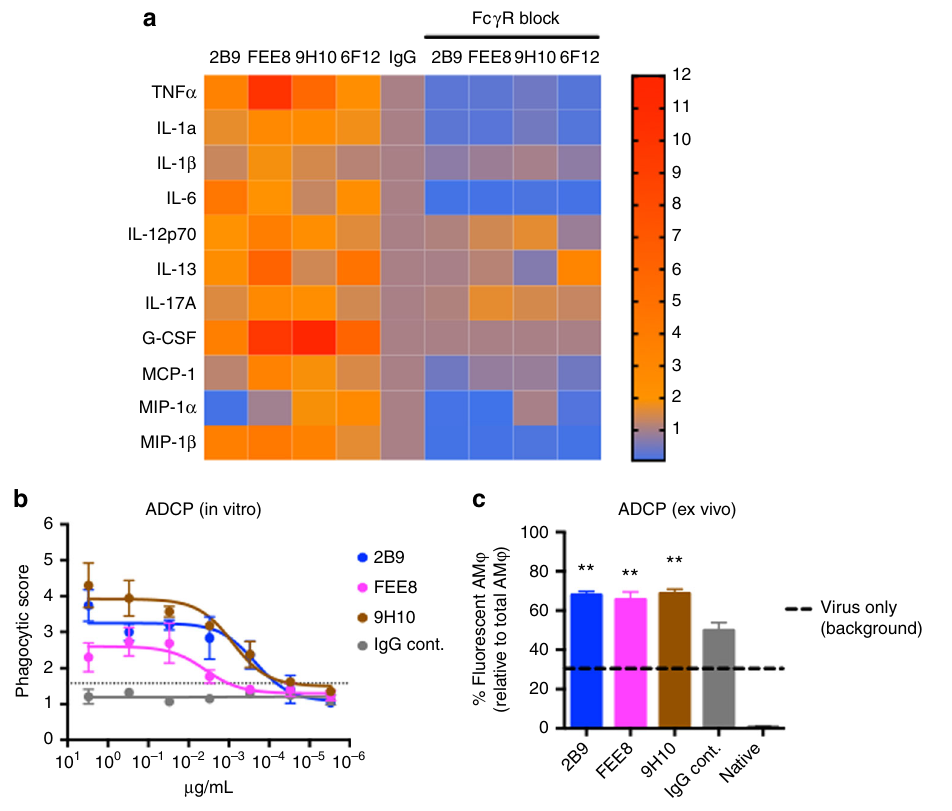
Fig. 8 NonNAb and bNAb are capable of activating AM φ effector functions. a Mouse primary AM φ isolated from BALF were incubated with 50 µ g per mL of indicated mAb and X31-infected A549 cells. Seventy-two hours later, supernatants were collected and cytokine/chemokine levels were measured by multiplex bead array assay. The heat map (generated by GraphPad Prism) represents fold changes of cytokine and chemokine levels in supernatants from indicated treatments. Values are normalized to corresponding IgG controls ( n = 3). b An in vitro ADCP assay was performed using THP-1 cells. HA-coated fl uorescent beads were incubated with each antibody before added to THP-1 cells. Samples were analyzed by fl ow cytometry and the phagocytic score was determined. c Puri fi ed preparations of X31 labeled with a pH-sensitive fl uorescent dye were incubated with mAb 2B9, FEE8, or 9H10 before administered intranasally into naive BALB/c mice. Two hours after infection, lungs were collected and internalized fl uorescent-labeled viral particles in AM φ were assessed by fl ow cytometry. The percentage of AM φ with internalized virus particles over total AM φ was calculated. Values represent mean ± SD; the experiment was done in triplicates. One-way ANOVA and Dunnett ’ s multiple comparisons tests were used to determine statistical signi fi cance (GraphPad Prism). For all panels: * P ≤ 0.05, ** P ≤ 0.01, *** P ≤ 0.001; NS, not signi fi